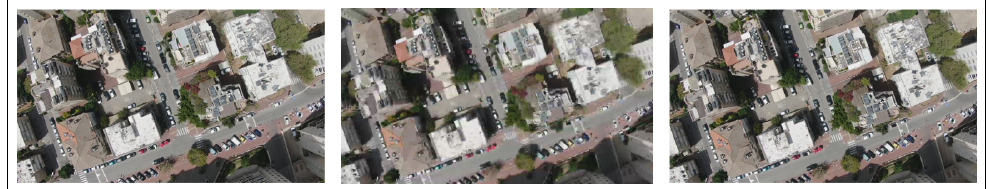
Figure 17. Example of three frames from a flight in a unchanging direction; the frame in the center is blurry; this causes a false positive due to the decreased correlation between the